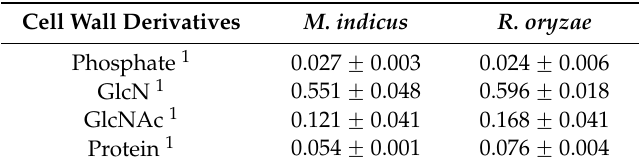
Table 3. Cell wall analysis of fungal biomass obtained from airlift bioreactor without any auxiliary nutrients. Data are mean ˘ SD and n = at least